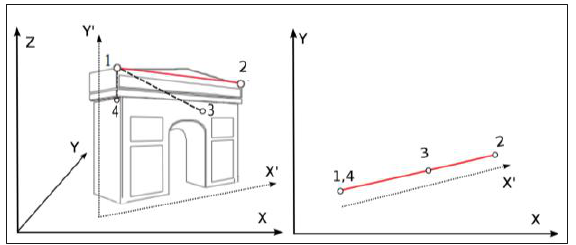
Figure 4: Select 2 points to define the rotation angle.